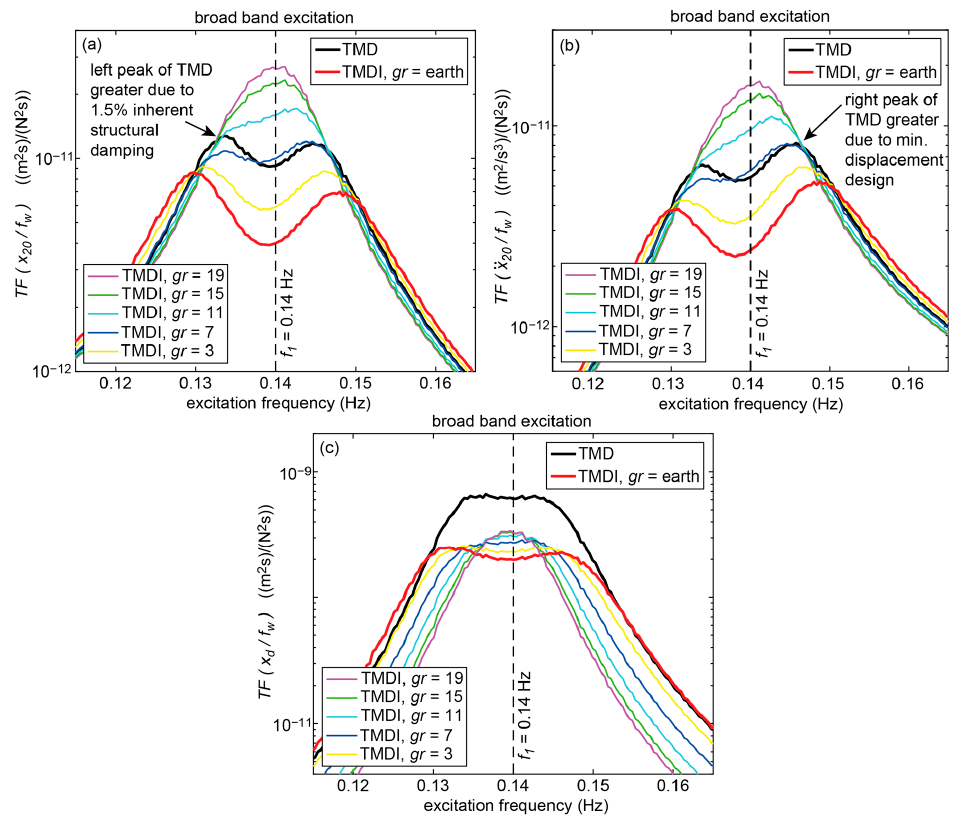
Figure 4. Results for the frequency range of mode 1: ( a ) transfer function between the structural displacement of level 20 and the excitation force; ( b ) transfer function between the structural acceleration of level 20 and the excitation force; ( c ) transfer function between the relative pendulum motion and the excitation force.